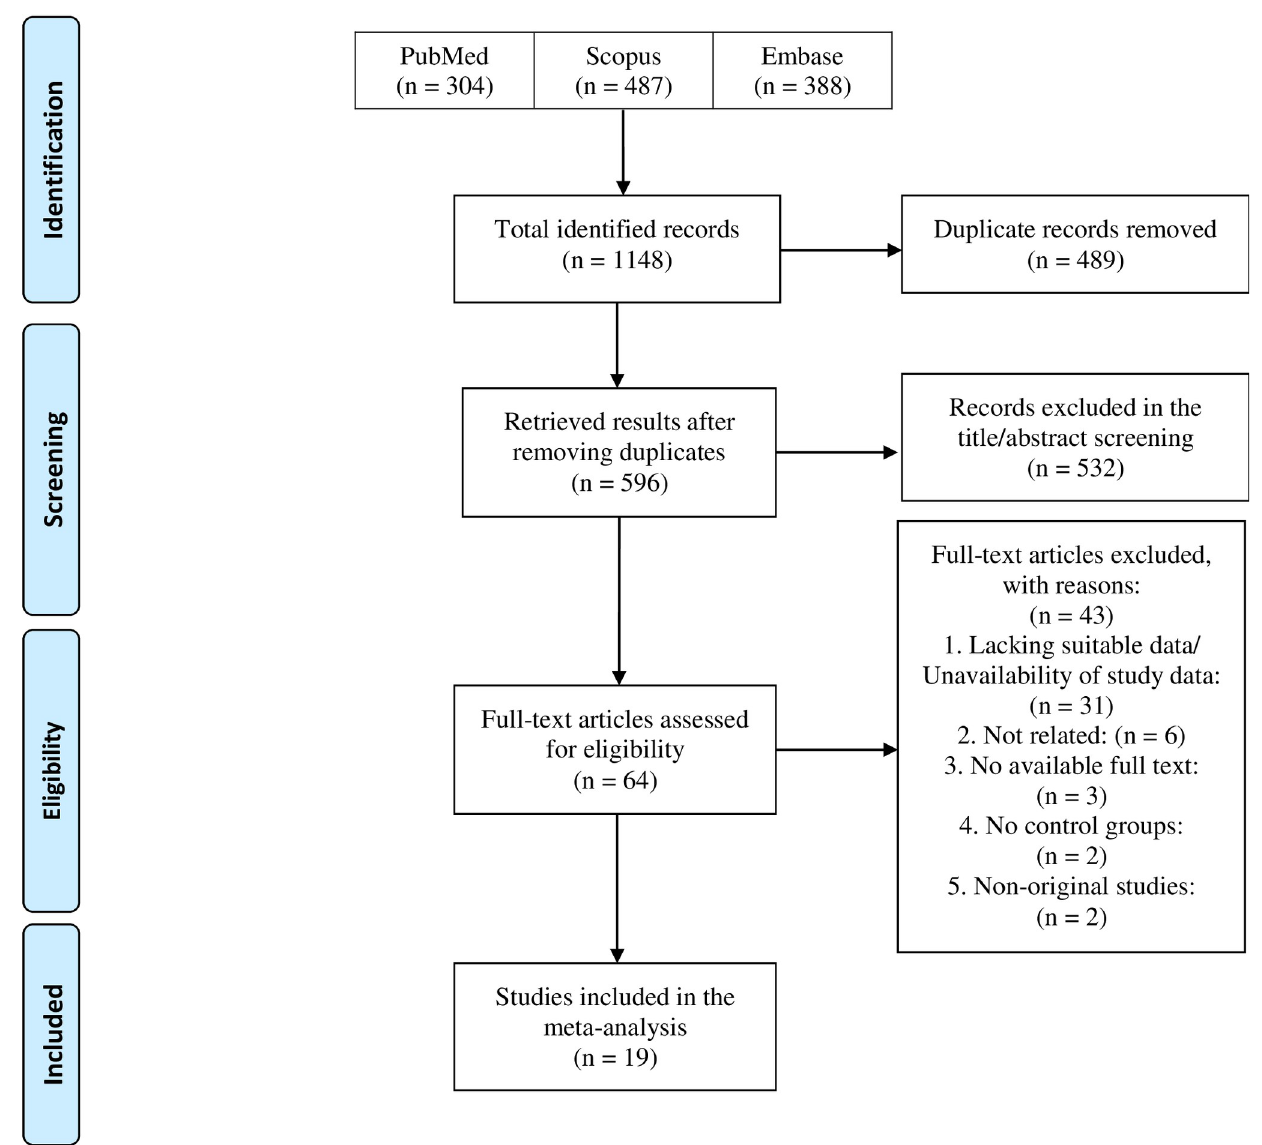
Fig 1. PRISMA flow diagram of the study’s selection